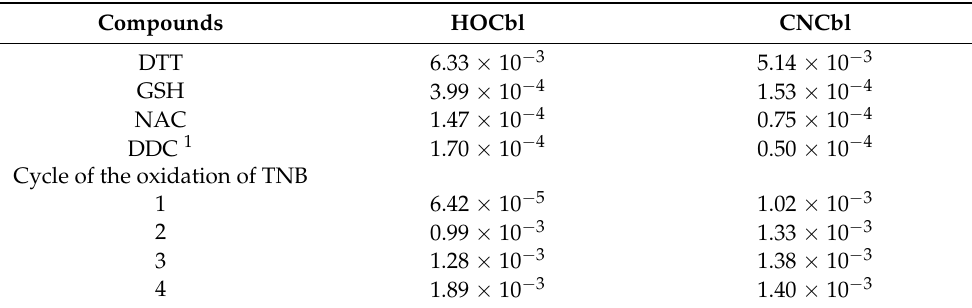
Table 1. Pseudo-first-order rate constants (k obs , s − 1 ) for the oxidation of sulfur-containing compounds in the presence of